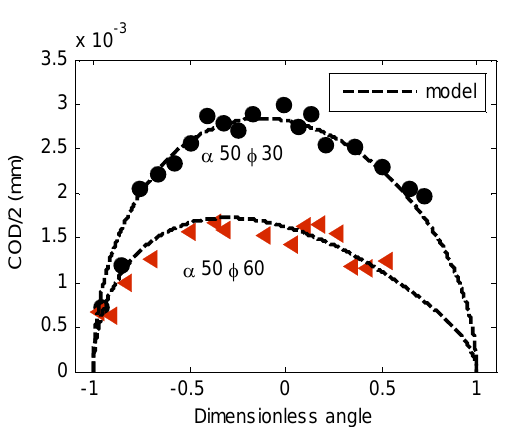
Figure 9: t = 5mm; crack length 2  (  0°) and (  0°).